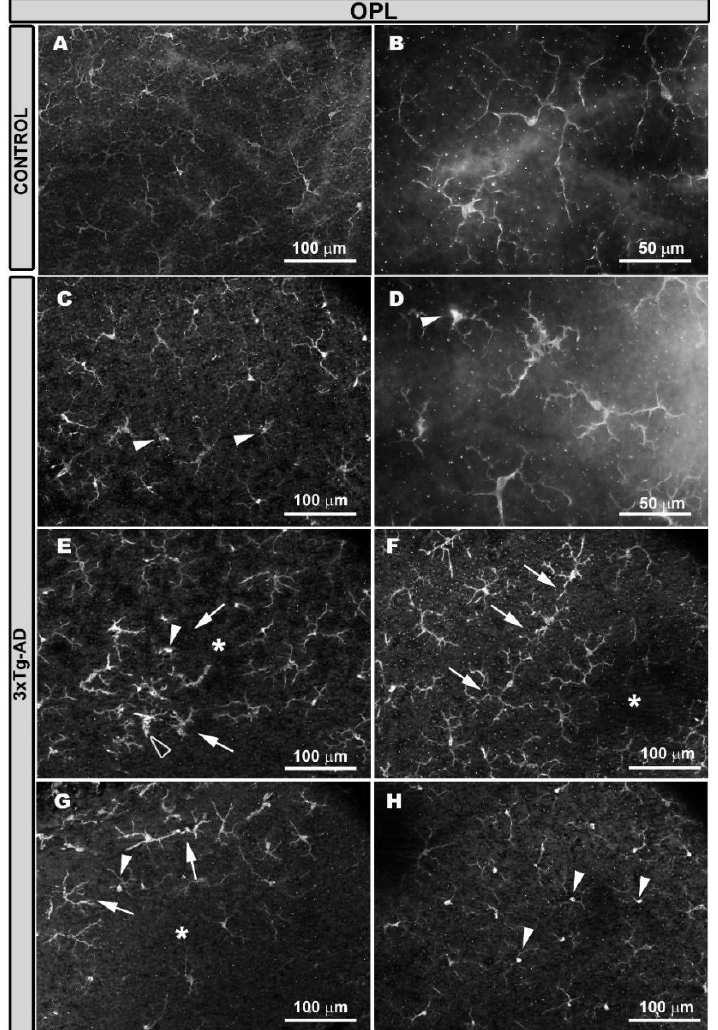
Figure 1. Iba-1 + cells in the outer plexiform layer (OPL). The retinal whole-mount labelled with anti-Iba-1. In the age-matched control animals’ eyes ( A , B ), Iba1 + cells have a ramified morphology and constitute a regular plexus of tiled cells throughout the retina. In 3xTg-AD animals ( C – H ), soma thickening and process retraction were observed in the Iba-1 + cells ( C , D ). The mosaic-like structure had disappeared in some areas of the retina ( D – G ) because there were areas of cell grouping (arrows) at the expense of areas without cells (*). These groups of cells can be circular ( E ) or oriented in rows ( F , G ); cells perpendicular to the retinal surface (the white arrowhead in E and G ) and amoeboid cells (hollow arrowhead in E ) can also be observed. Iba-1 + perpendicular cells in some areas of the retina occupied large zones (the white arrowhead in H